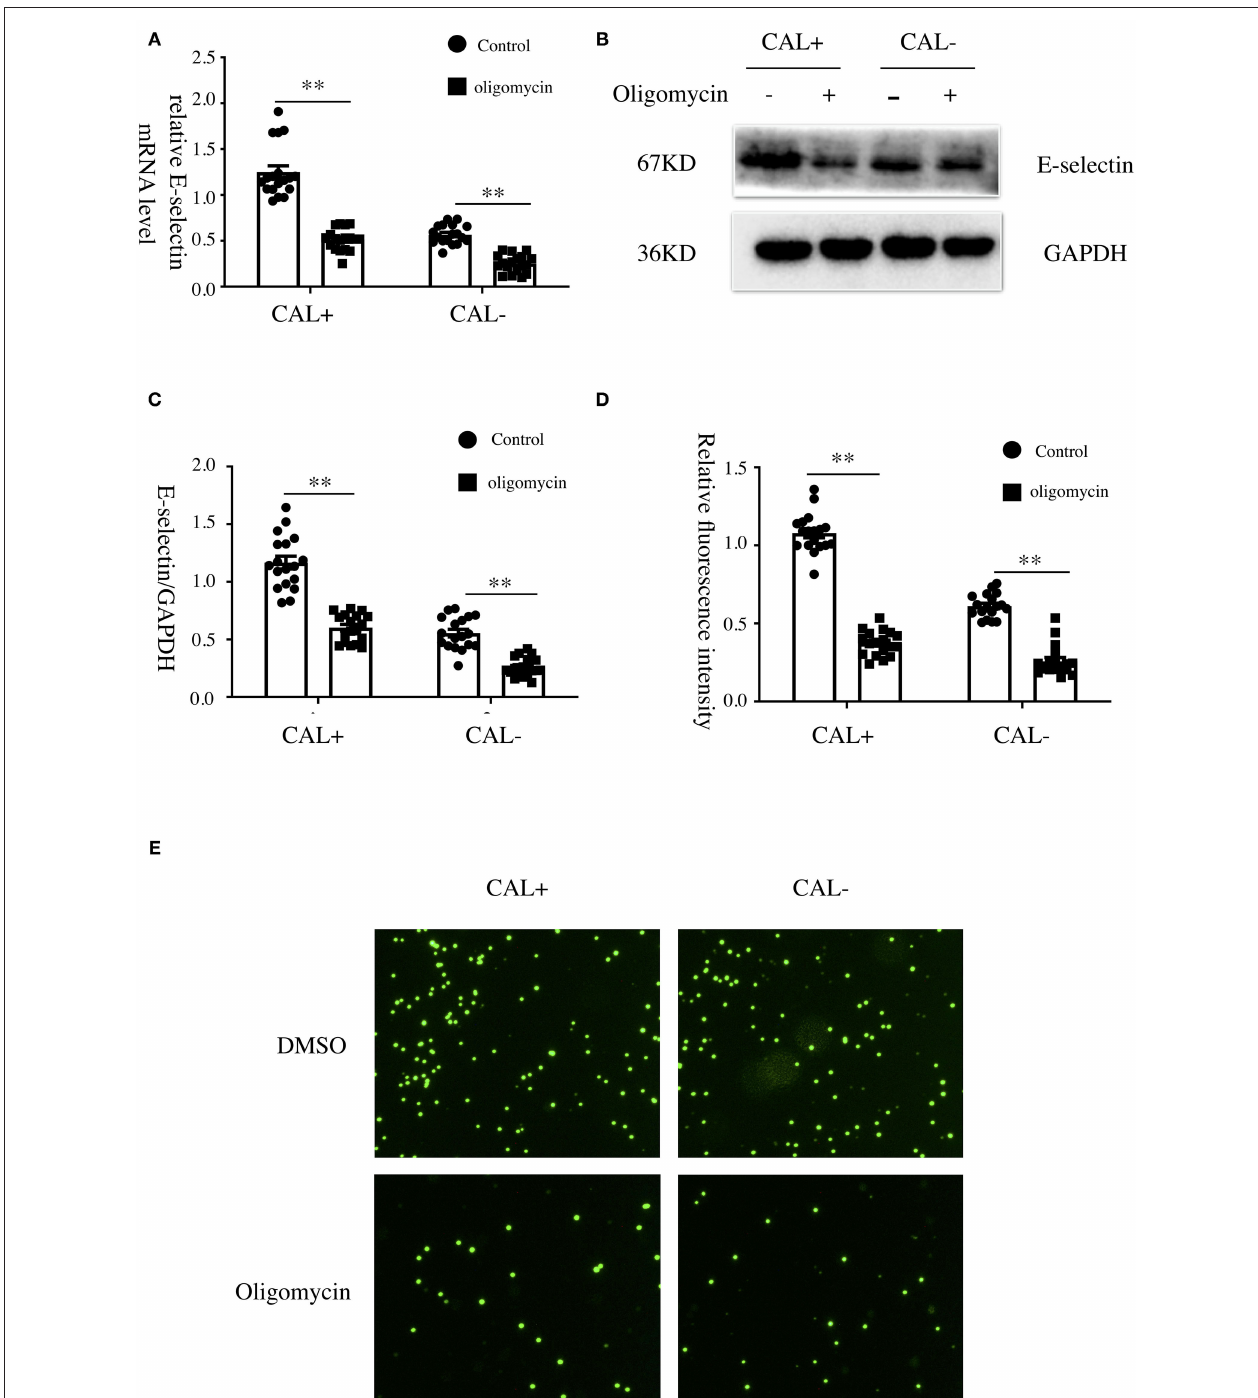
FIGURE 5 | Oxidative phosphorylation was involved in the expression of E-selectin and monocyte–endothelial cell interaction. (A–E) Human coronary artery endothelial cells (HCAECs) were treated with medium containing 15% sera from Kawasaki disease without coronary artery lesion (KD-CAL–; n = 6) and Kawasaki disease with coronary artery lesion (KD-CAL + ; n = 6) subjects plus oligomycin (50 µ g/ml) or DMSO (same volume) for 4h. The E-selectin mRNA levels were measured by qPCR (A) , and protein levels were measured by Western blot (B) . (C) Statistical analysis of immunoblots. (E) HCAECs were treated with medium containing 15% sera from KD-CAL– ( n = 6) and KD-CAL + ( n = 6) subjects plus oligomycin (50 µ g/ml) or DMSO (same volume) for 4h then co-incubated with 2 ′ ,7 ′ -bis-(2-carboxyethyl)-5-(and-6)-carboxyfluorescein acetoxymethyl ester (BCECF-AM)-labeled THP-1 cells for 1h. Representative images used quantification of THP-1 cells (green) attached to human umbilical vein endothelial cells (HUVECs). (D) Quantitative analysis of adherent THP-1 cells lysate fluorescence at 490-nm excitation and 530-nm emission. All samples were normalized to HCAECs with CAL serum treatment. The bar graphs are mean ± SEM. ** P < 0.01 compared with the indicated